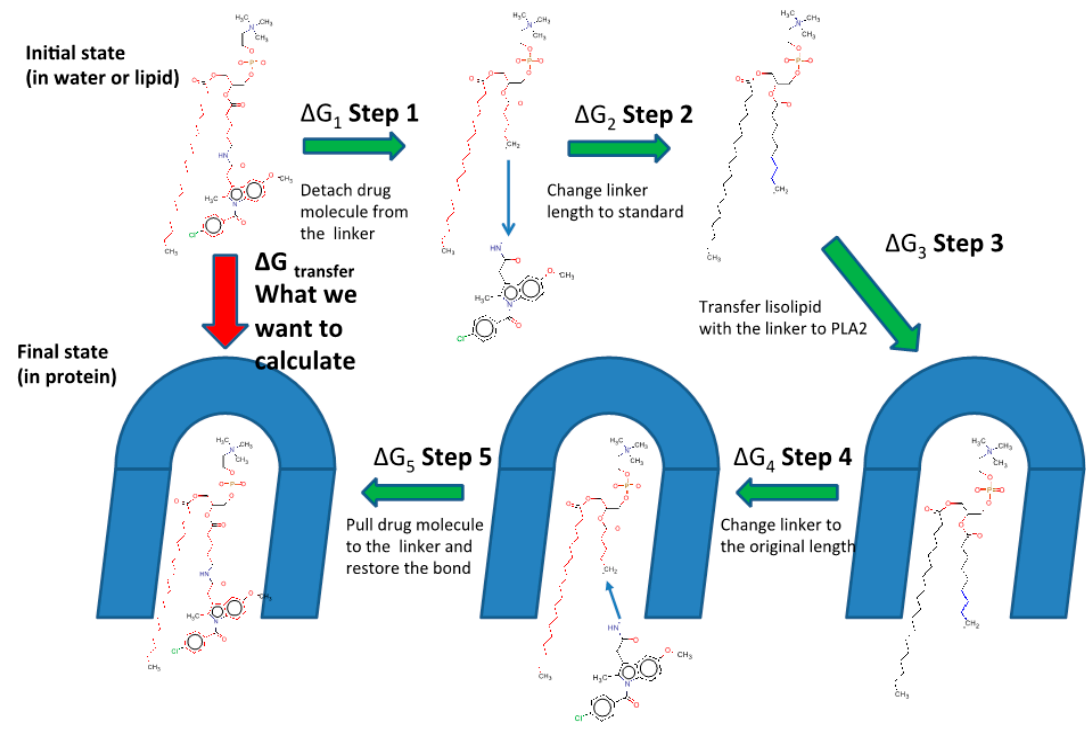
Figure 2. Alchemical cycle to compute free energy of the transfer of the PL-indomethacin prodrug molecules to the PLA 2 transition state geometry. ( Δ G 1 + Δ G 5 ), the energies for bond cutting/forming cancel out. Free energies of pulling the drug molecule to the end of the linker are computed using the umbrella sampling technique. ( Δ G 2 + Δ G 4 ), the differences in free energies of changing the linker length in the complex with PLA 2 and in the initial state (lipid or water) are computed using the free energy perturbation (FEP) method.